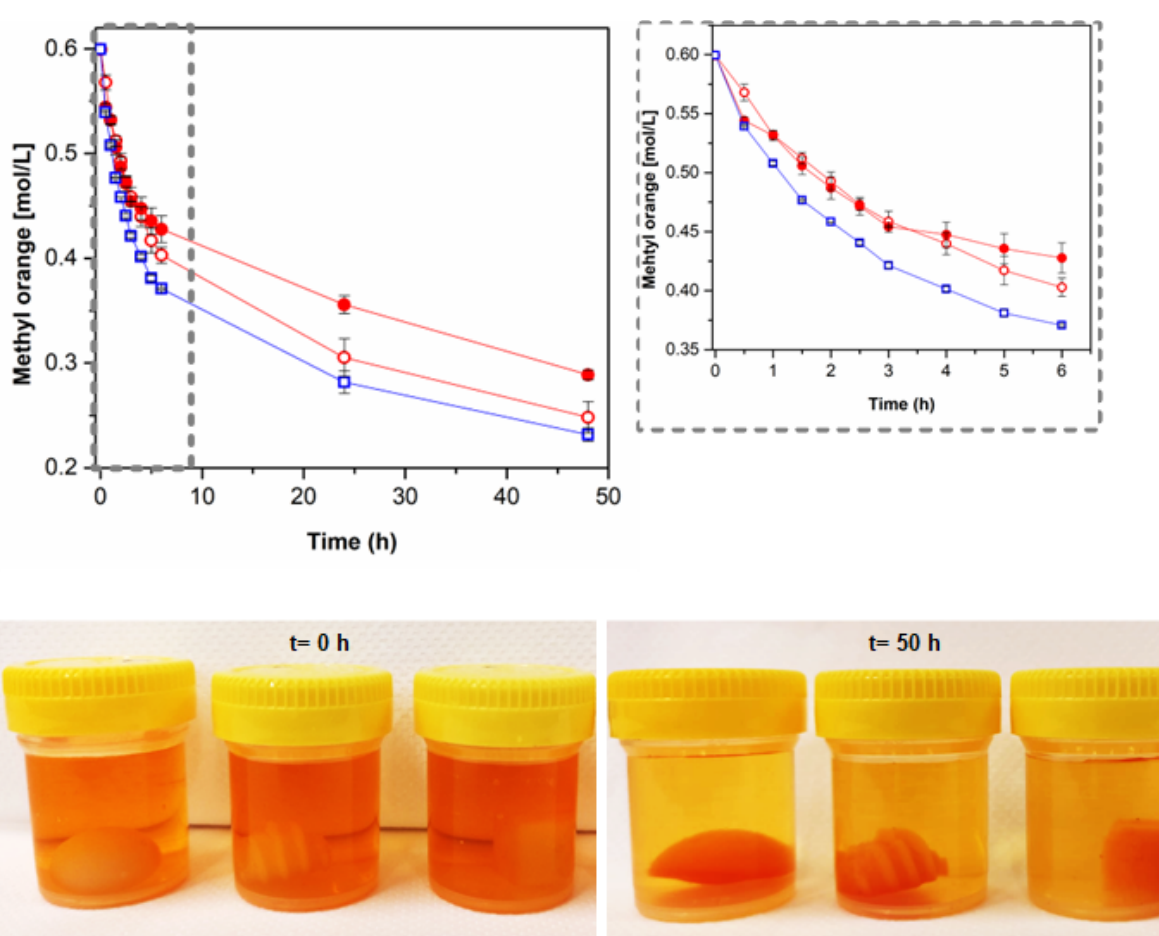
Figure 4. Effect of geometry and hierarchical roughness of polycationic hydrogels onto the sorption capacity of anionic model molecule (methyl orange [0.0625 mM]) at room temperature (~23 °C) ( A ) and illustration of each aqueous media before and after the contact with the samples ( B ). The hy- drogels were coded as: CS-Sph ( ), CS-Sph r ( ) and CS-Cub ( ).